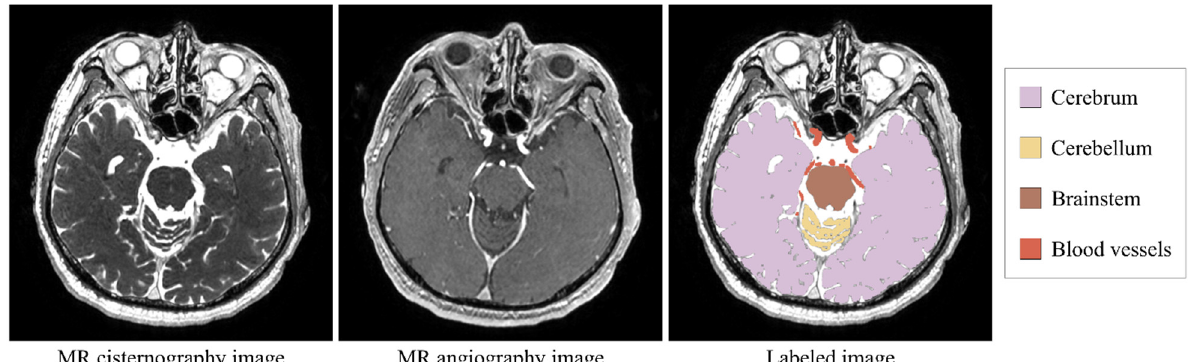
Figure 1. MR images used in this study.